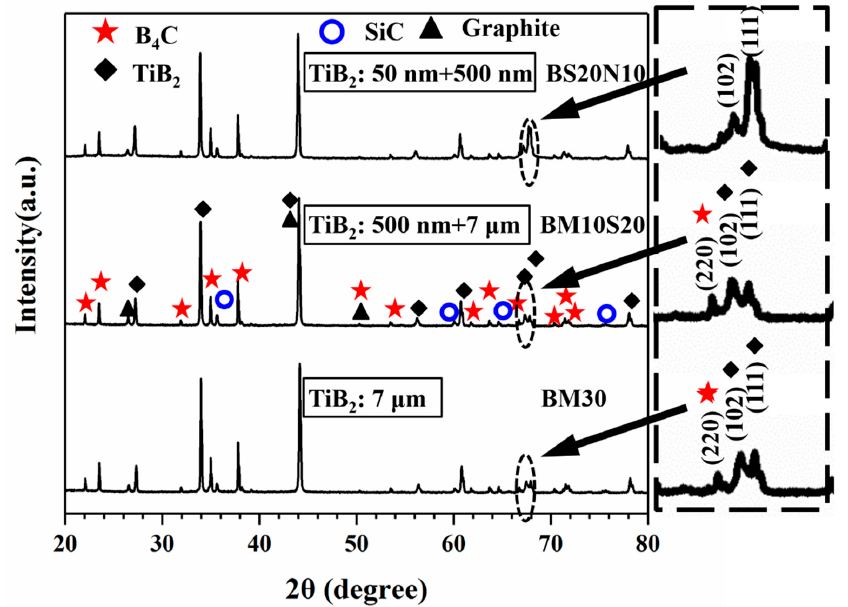
Figure 2. XRD patterns of B 4 C/TiB 2 ceramic composites obtained with different grades of TiB 2 powders.